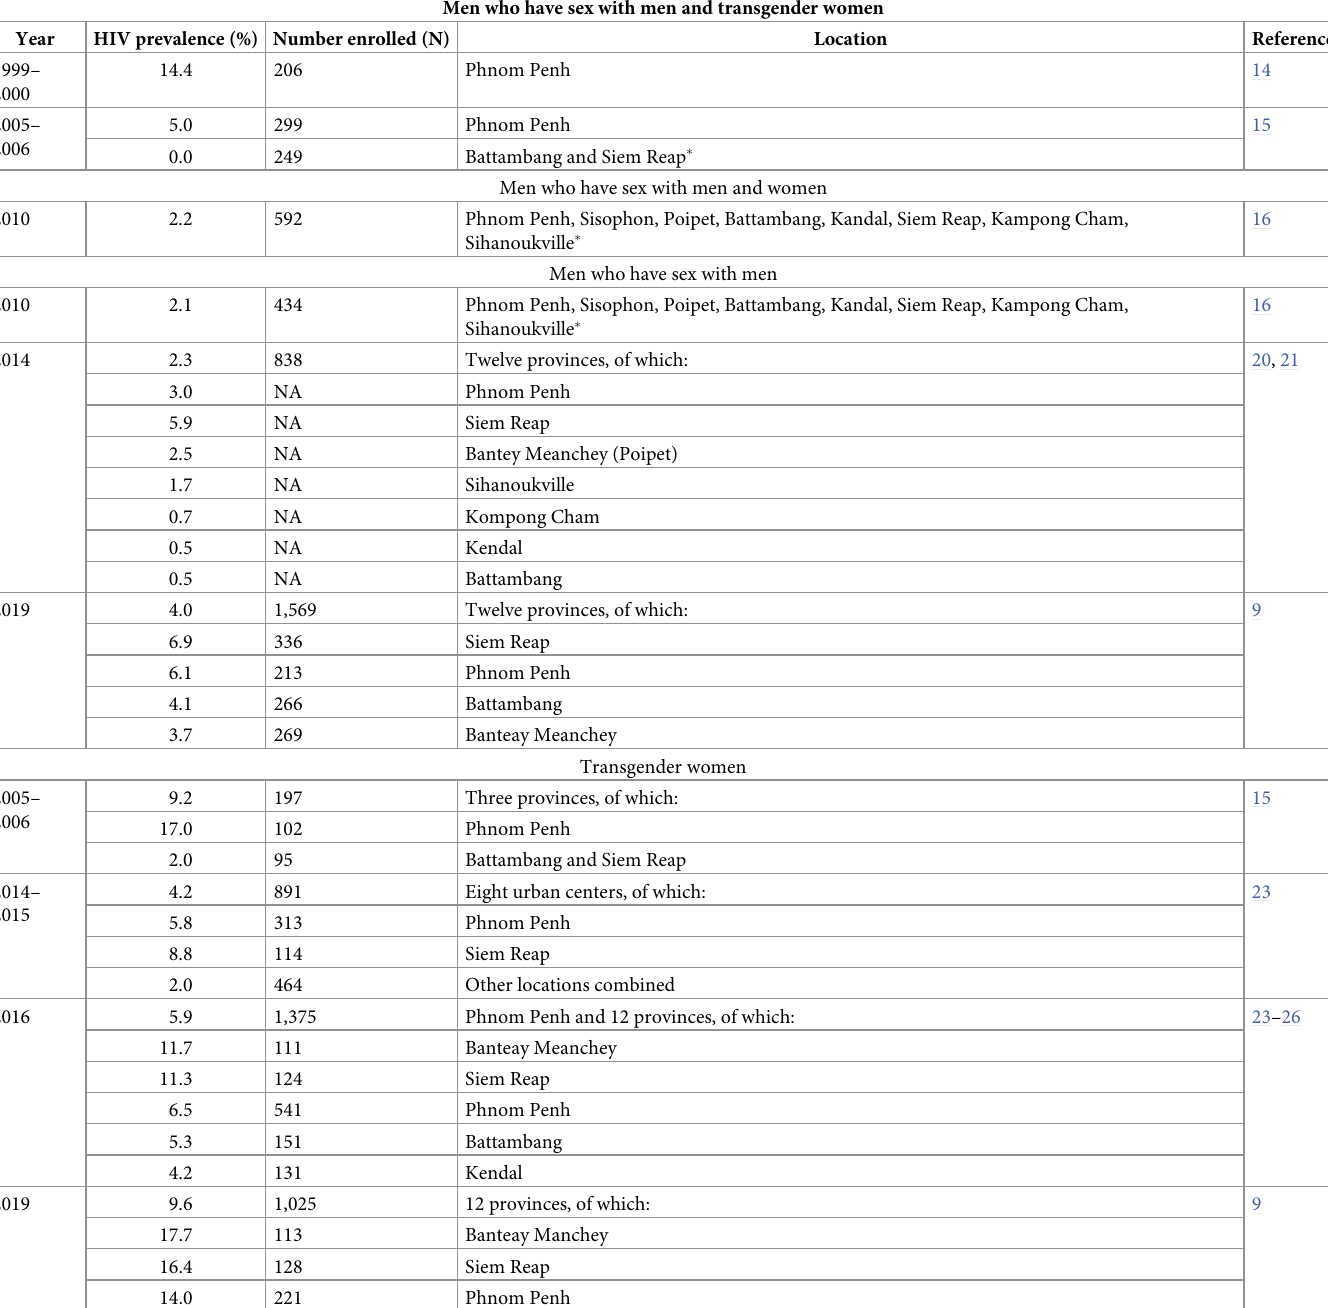
Table 1. HIV prevalence among populations of men who have sex with men and transgender women in Cambodia,